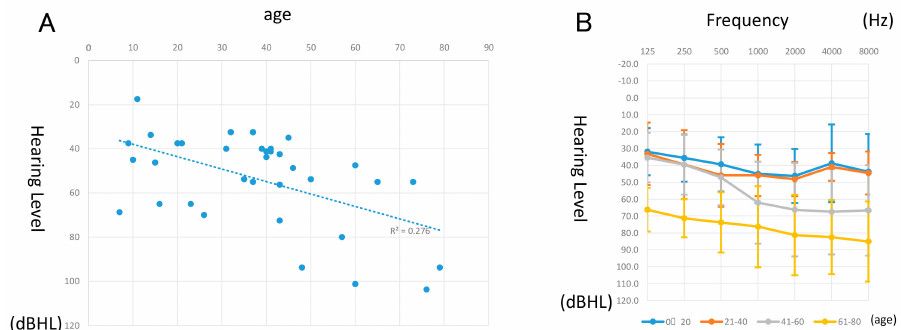
Figure 3. Hearing loss deterioration in patients with MYO6 mutations. ( A ) Correlation between age and hearing. Pure-tone averages of each patient were plotted by dB hearing level (HL) and age at the time of the hearing test. ( B ) Average hearing threshold for each 20-year age group for patients with MYO6 mutations. A total of 8 cases were indicated in the 0 − 20, 11 in the 21 − 40, 12 in the 41 − 60, and 4 in the 60 or